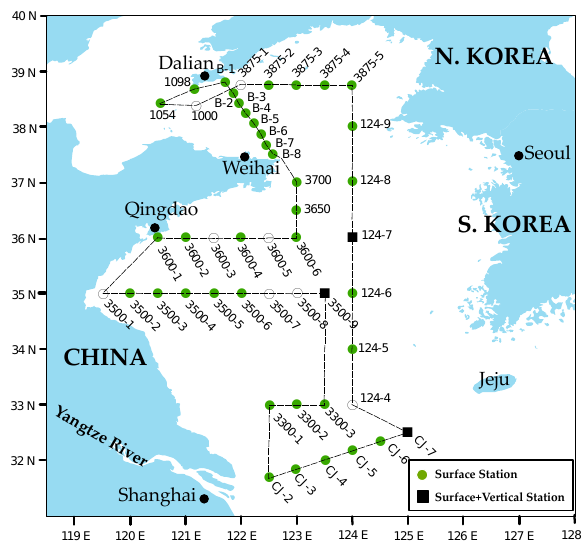
Fig. 1. Cruise track and all stations and stations sampled for Hg in the open cruise 2010 organized by IOCAS along Qingdao–Dalian– Shanghai–Qingdao. Begin day/Station: 9 July 2010/3600–1. End day/Station: 18 July 2010